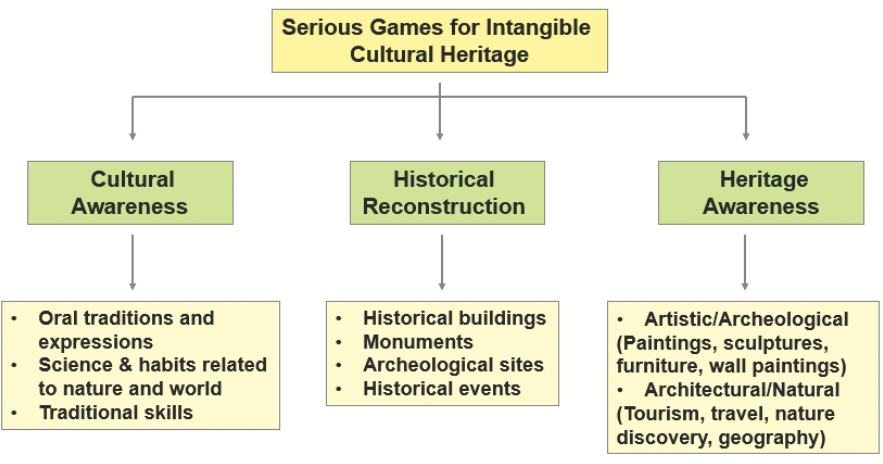
Figure 1. Categorization of serious games’